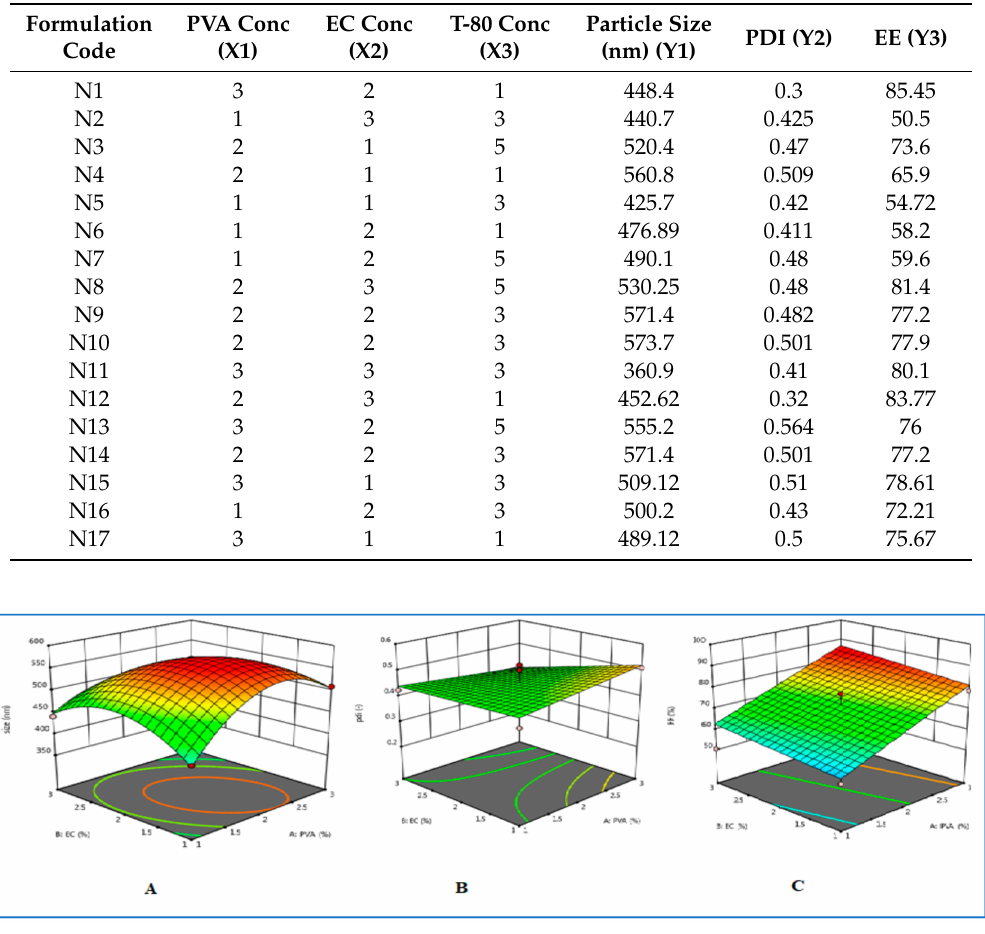
Figure 2. ( A ) Contour plot depicting size based on the concentration of PVA and EC% ( B ) Contour plot depicting PDI based on the concentration of PVA and EC% ( C ) Contour plot depicting entrapment e ffi ciency based on the concentration of PVA and